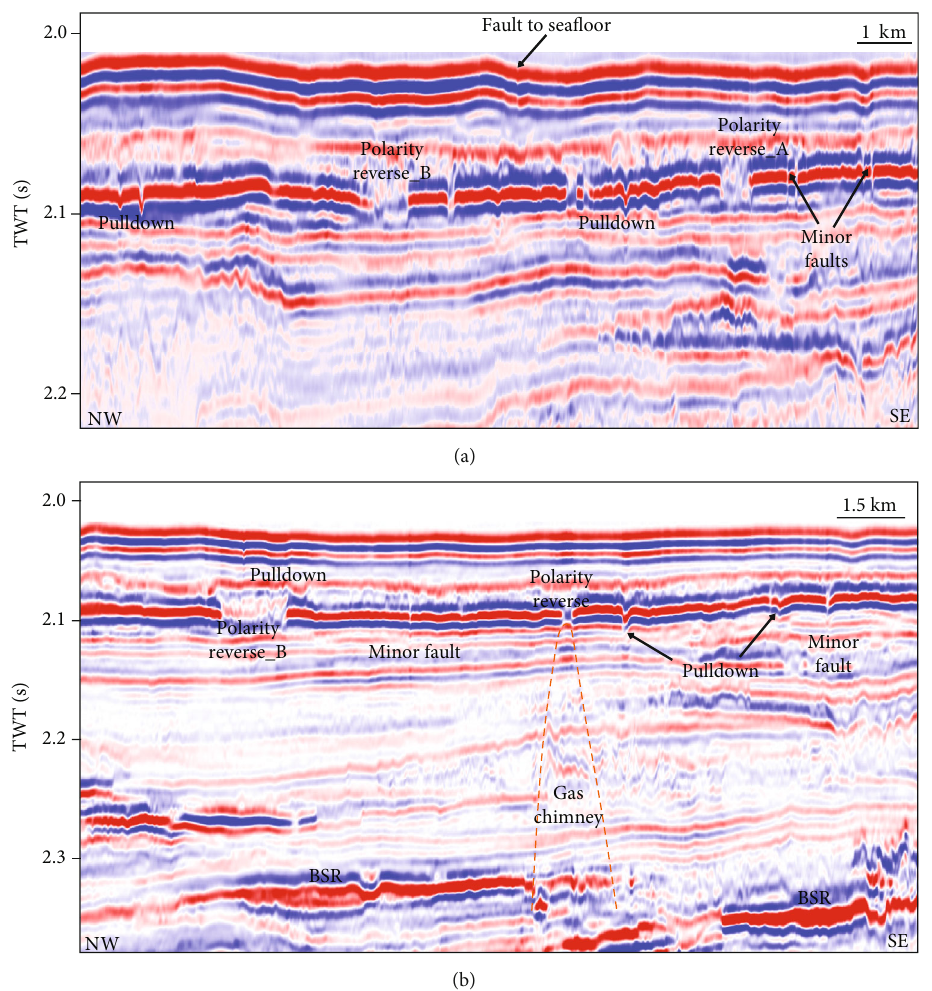
Figure 3: Seismic anomalies shown in the sections (see their locations in Figure 1(b)).